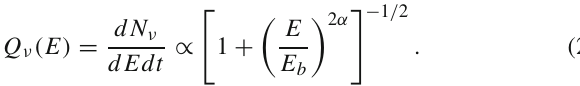
Table 1: upper (black continuous curve), Fiducial (red dashed curve) and Lower (blue dotted curve). It is possible to observe how the maximum contribution comes from 1 (cid:3) z (cid:3) 4, for all the